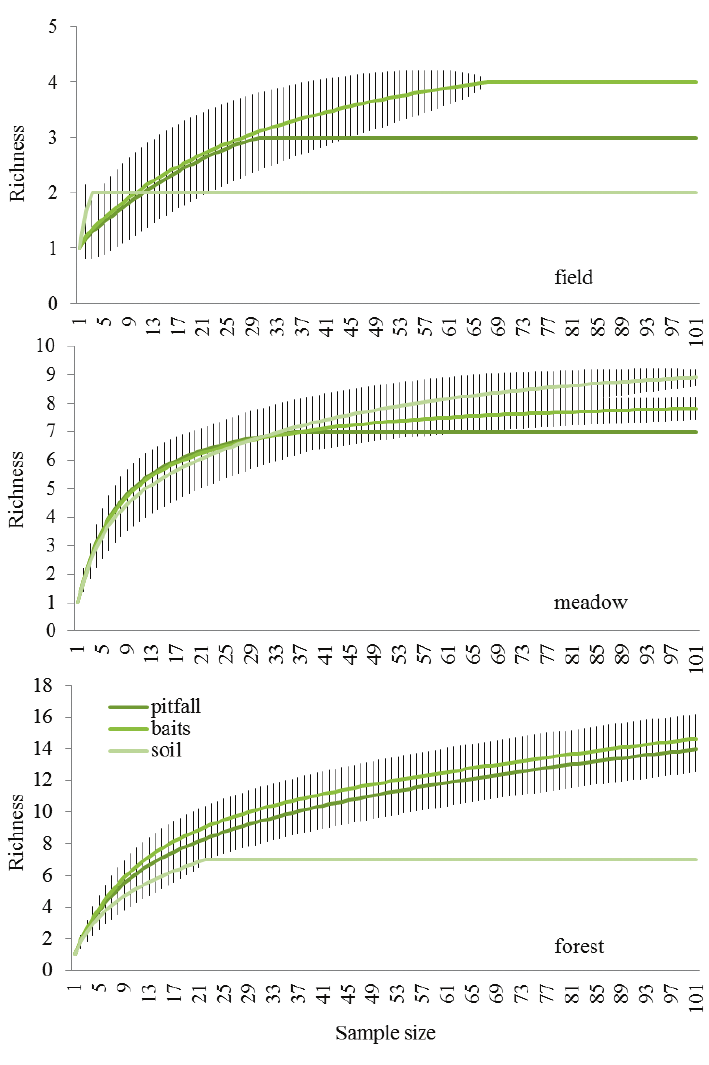
Figure 1. Rarefactions of estimated species richness (i.e. number of species) in increasing size of random samples (i.e. number of individuals), comparison of effectiveness of sampling by individual methods at different sites. Vertical lines represent standard errors.